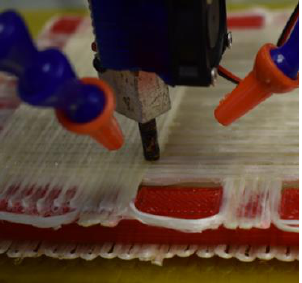
Figure 13. Placement of Top Facesheet onto Core.